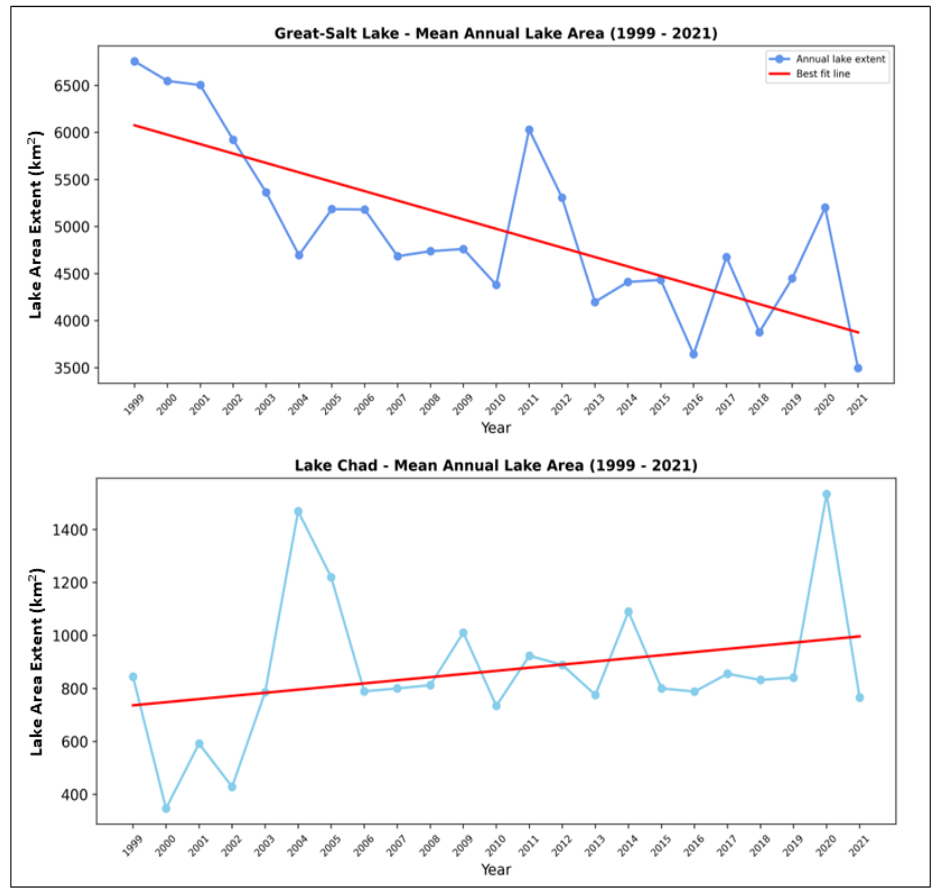
Figure 5. A comparative plot of lake surface area changes of GSL ( top ) and LC ( bottom ) between 1999 and 2021.